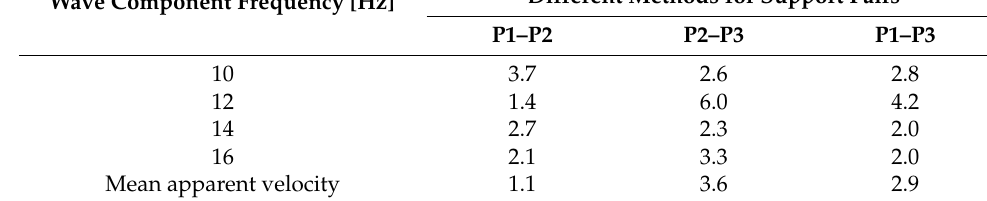
Table 6. The differences in the wave velocities obtained from the cross-correlation and the phase angle method for particular support pairs.